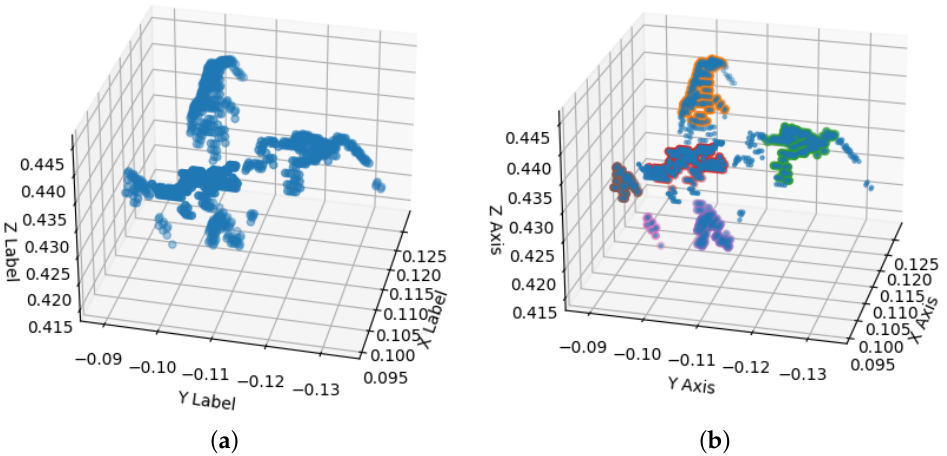
Figure 11. Mean shift segmentation. ( a ) The development of a second stage seedling. ( b ) The segmented and counted leaves using the mean shift technique. In red and orange, we show the cotyledons, the first genuine leaf in brown and green, and the stem in